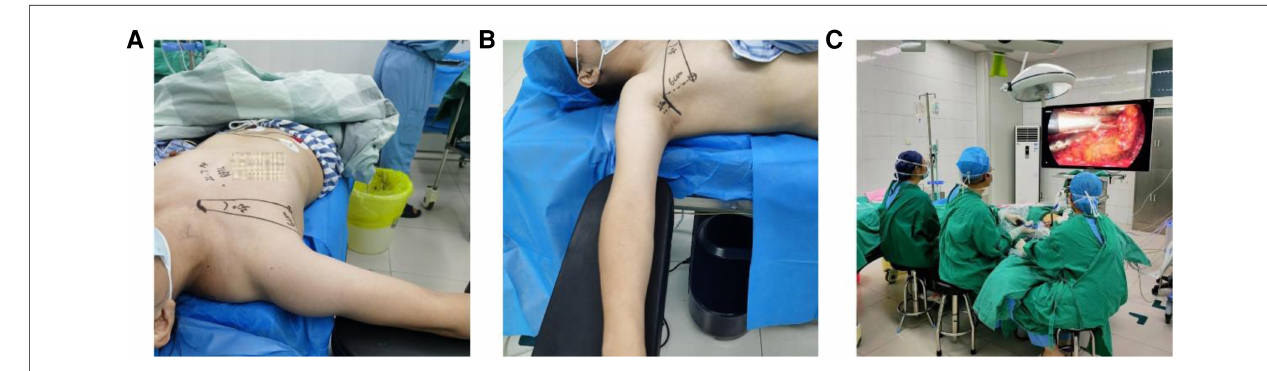
FIGURE 1 Patient ’ s posture and surgeon ’ s seat. ( A ) Place the operated side body close to the edge of the surgical bed. ( B ) The arm was abducted at 90°. ( C ) The HD monitor was placed contralateral, and the surgeon and assistant were then seated on either side of the patient ’ s